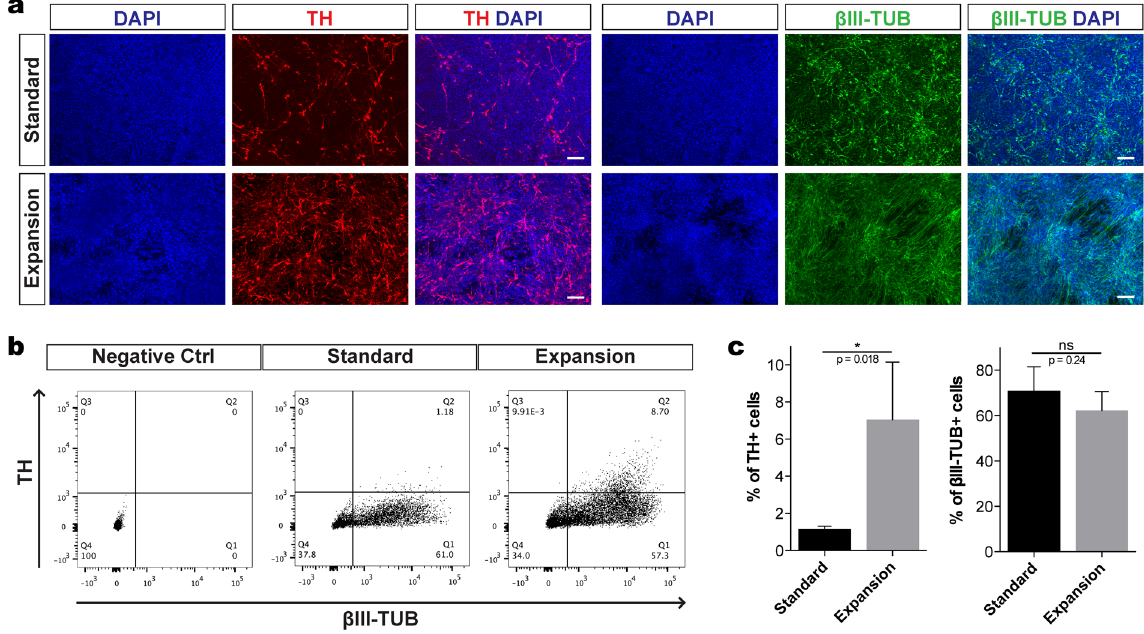
Figure 3. hiPSC-derived expanded mFPPs give rise to higher numbers of TH + neurons at an early stage of DA neuron differentiation. ( a ) Immunocytochemical analysis of DA neurons generated by using the expansion method showed higher proportion of TH + neurons compared to the standard protocol. Cells were stained with antibodies against TH and β III-Tub (Table S1). ( b ) Dot plots of single-cell suspensions of one representative differentiation experiment using the expansion method showed higher percentages of TH + β III-Tub + neurons generated at day 20 compared to the standard protocol (8.70% vs 1.18%). Negative control sample was used to determine the gating parameters for cell quantification. ( c ) Comparative analysis of total positive neurons for β III-Tub and TH markers generated at day 20 by using the standard method and the expansion protocol. Similar percentages of β III-Tub + neurons were measured using both protocols, suggesting that the progenitor expansion did not interfere with neuronal induction fate. Higher proportion of TH + cells were obtained after progenitor expansion (8.06 ± 2.45%) in comparison to the standard method (1.18 ± 0.14%), resulting in a 6.83- fold increase of TH + cells. Student’s t-test. Mean ± S.E.M. (n = 3–5). Scale bar: 50 μ m.